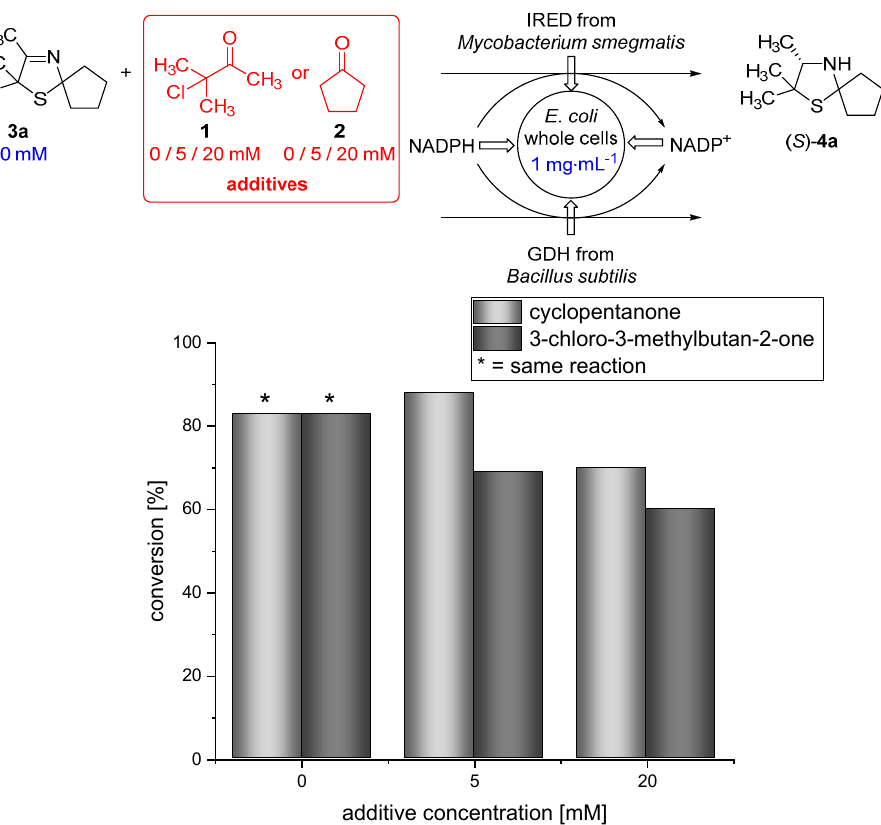
Figure 4. Results for the biotransformation of 3-thiazoline ( 3a ) in the presence of different concentrations of either cyclopentanone ( 2 ) or 3-chloro-3-methylbutan-2-one ( 1